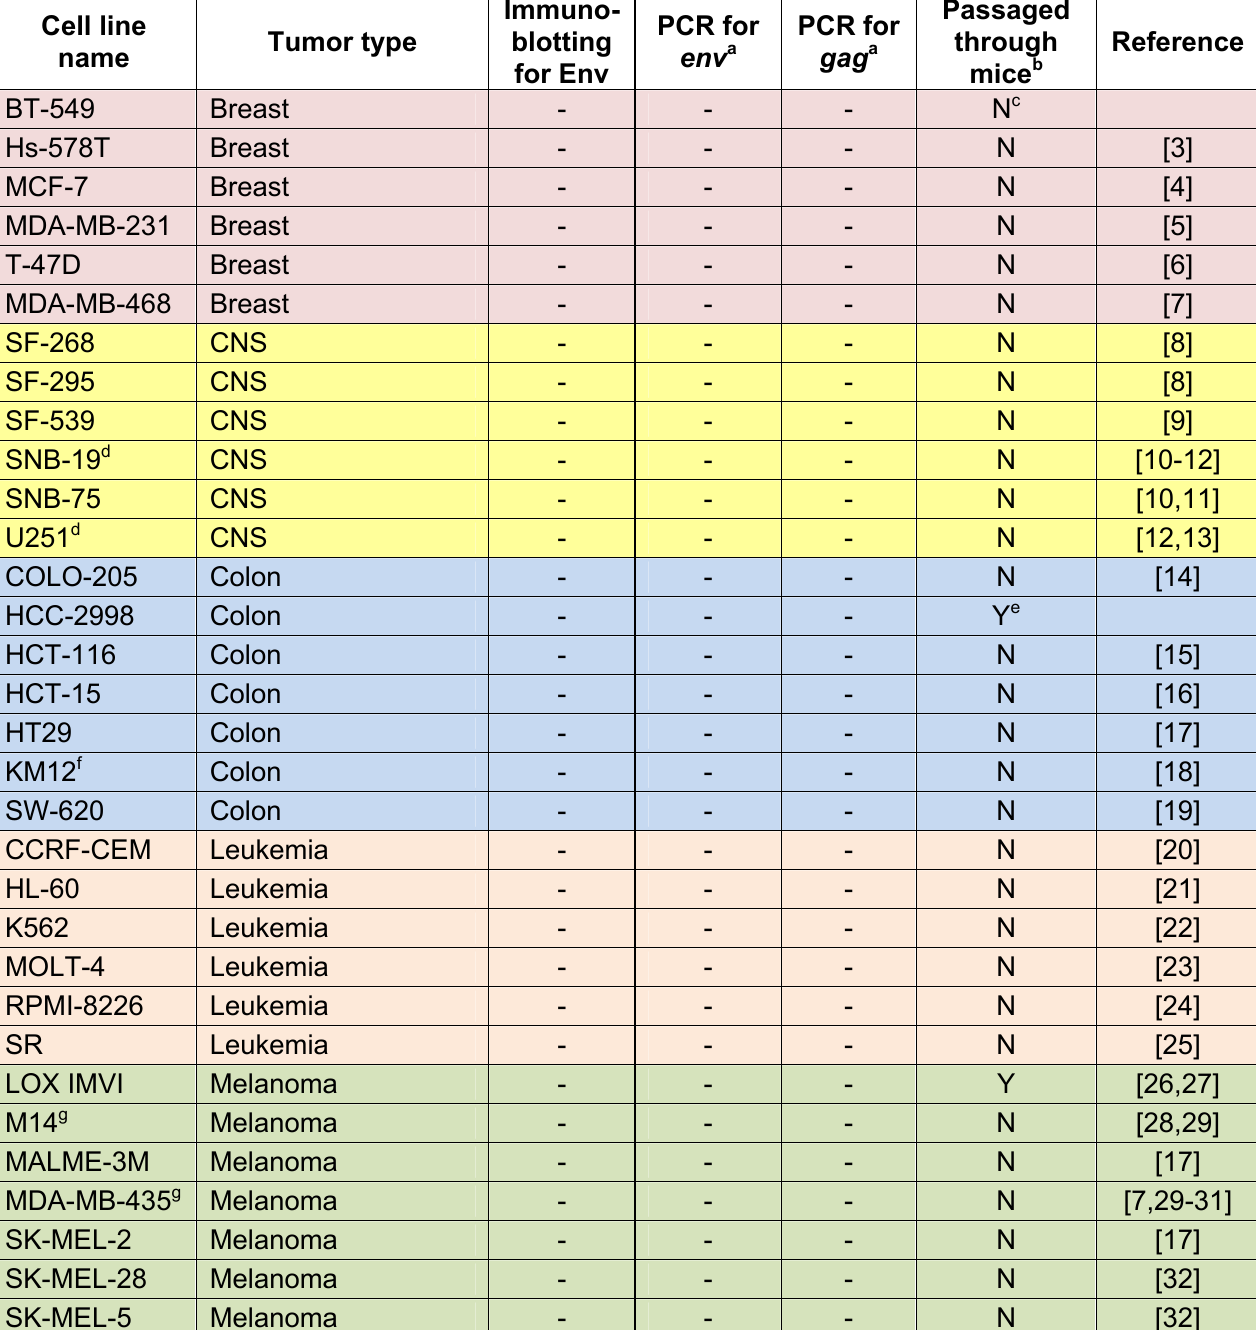
Table 1. Derivation of the cell lines of the NCI-60 panel and results of virus screening. Cell